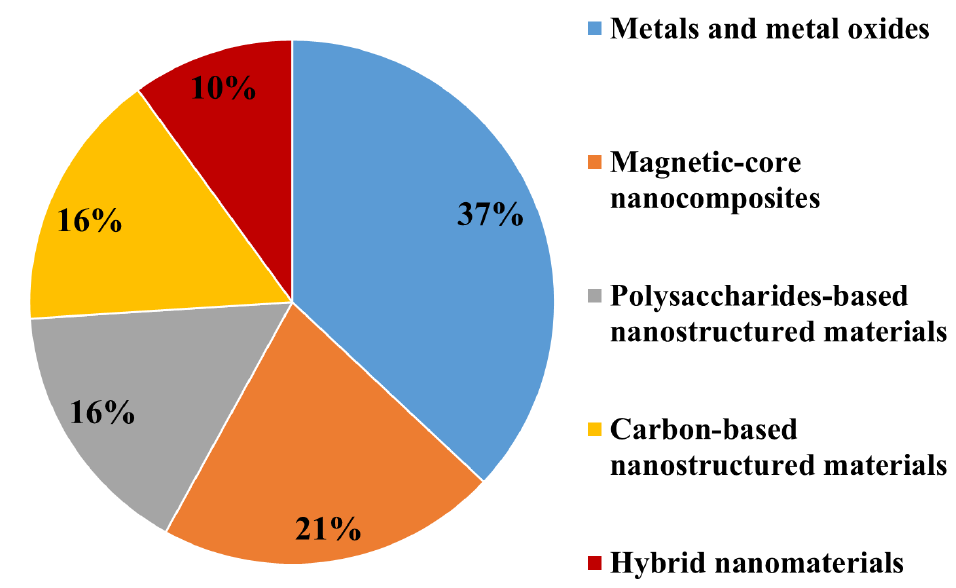
Figure 2. Classes of ENMs employed for marine environment nanoremediation.